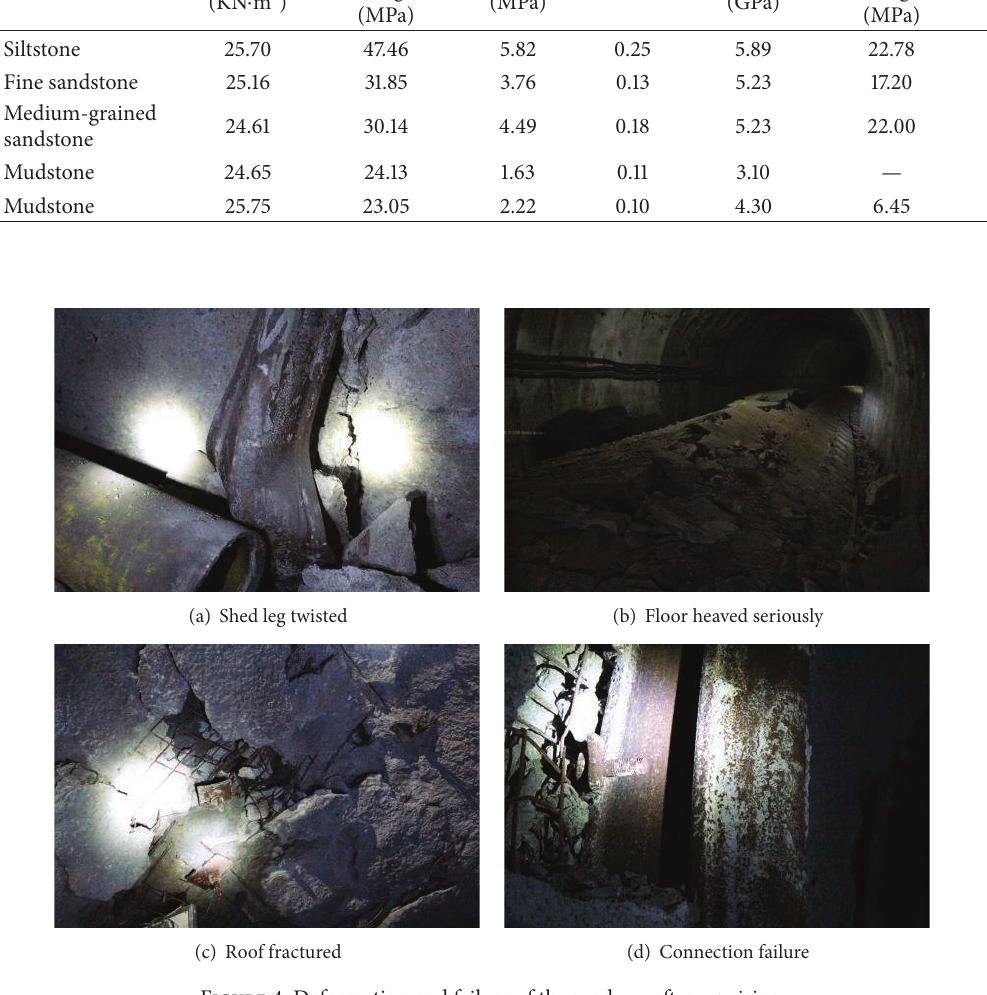
Figure 4: Deformation and failure of the roadway after repairing.